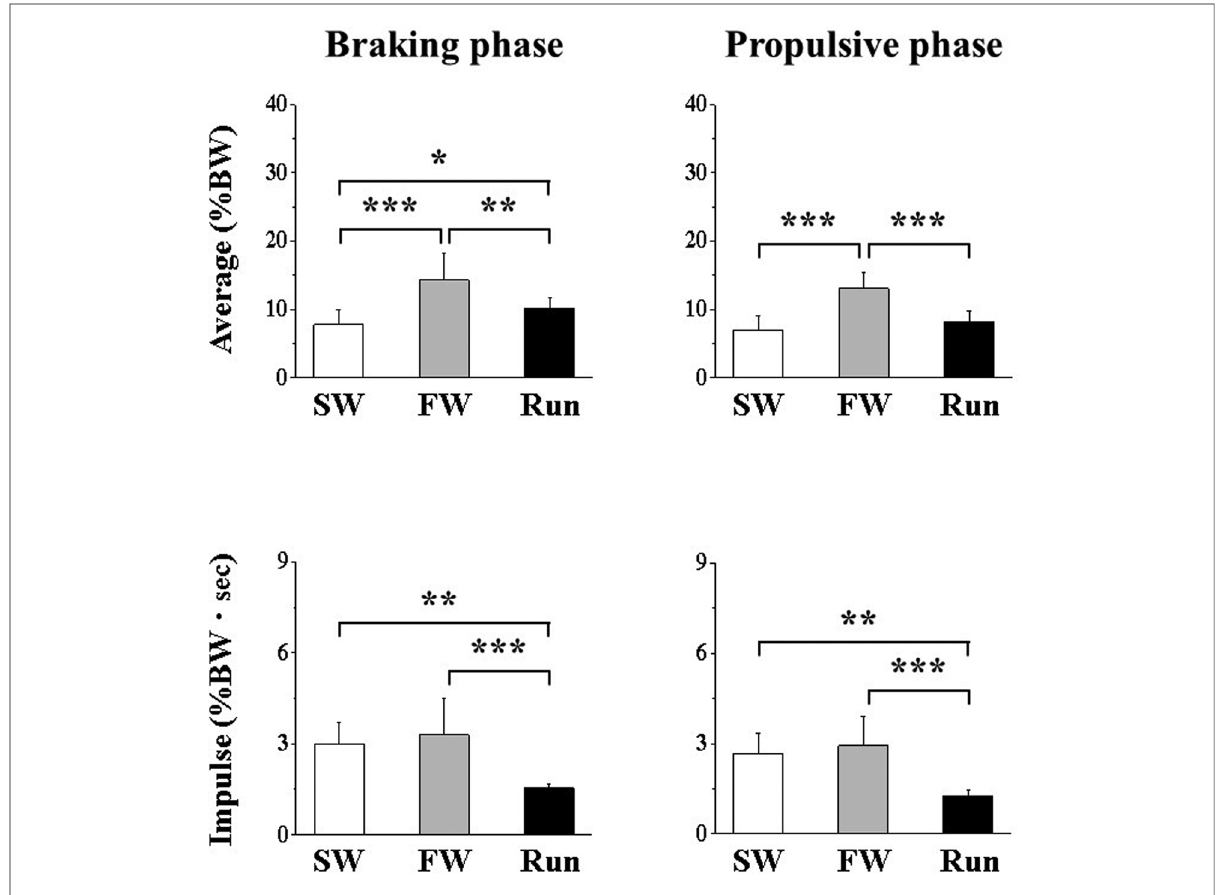
FIGURE 3 Anteroposterior component of ground reaction force during the braking ( A,B ) and propulsive ( C,D ) phases. Values are means±SD. Signi fi cant difference between trials (* p <0.05, ** p <0.01, *** p <0.001). SW; Slow walk trial. FW; Fast walk trial. Run; Run